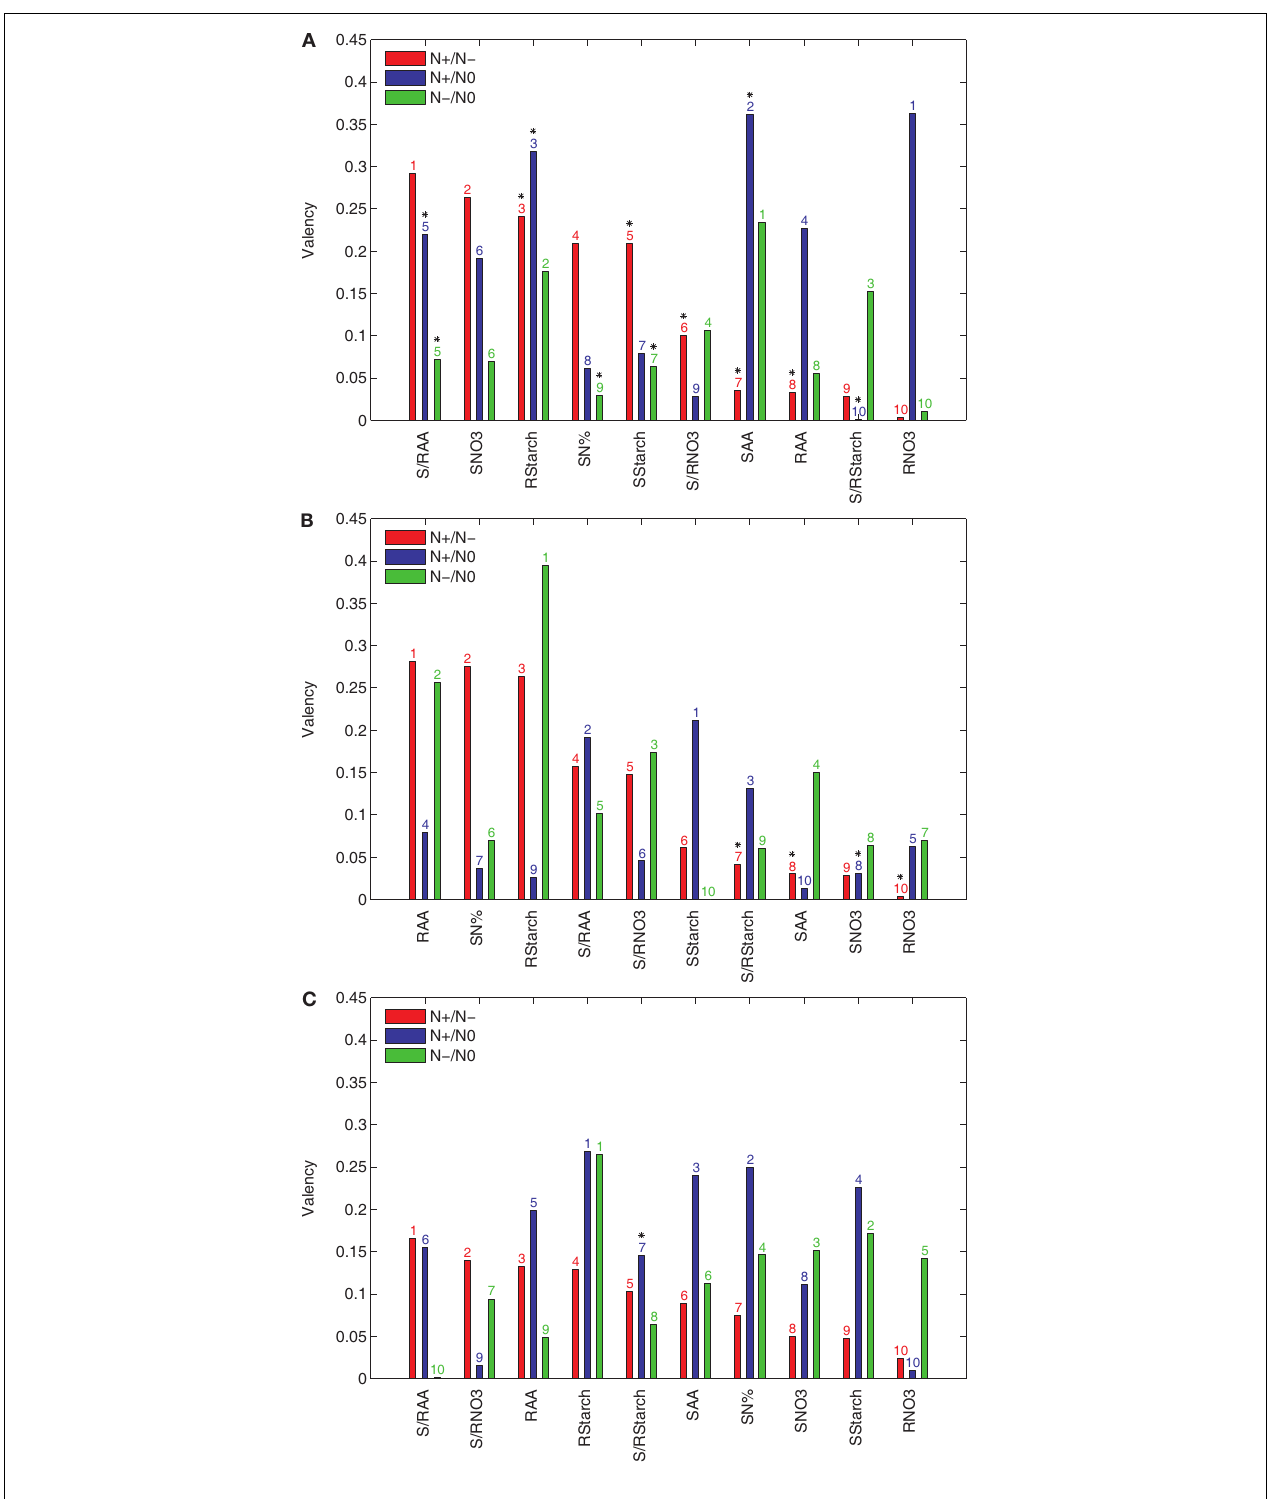
descending order of their valencies with respect to their effect in the comparison of N + and N − .The y -axis refers to the valency index ( ϕ ) of a particular metabolic trait in the comparative analysis of N + and N − (red), N + and N0 (blue), and N − and N0 (green) conditions.The ordering of metabolic traits for the different nitrogen availabilities is indicated above the bars. Significant Kendall is τ correlation ( p -value < 0.05) is marked with a black star above the bar